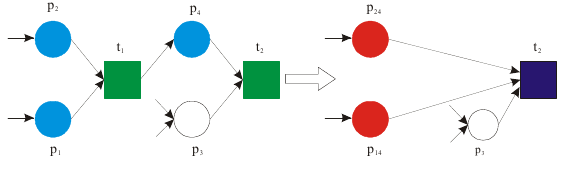
Fig.18. “AND” merge place reduction rule The “AND” merge place reduction process in Fig.18